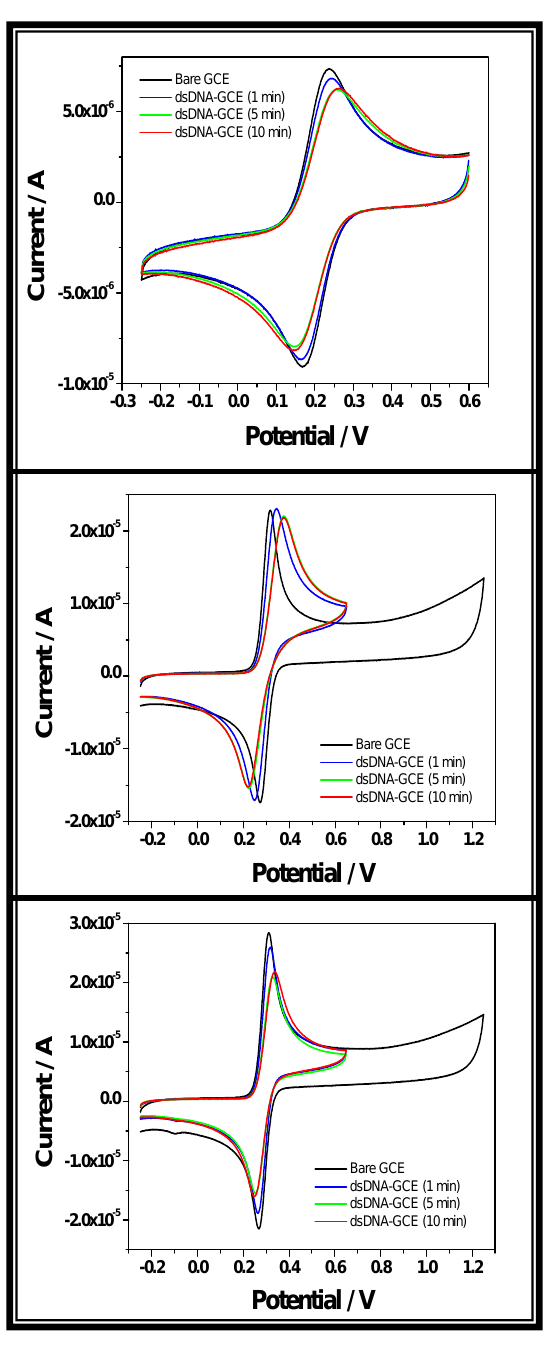
Figure 2. Cyclic voltammograms for 5.0 x 10 -4 M potassium ferricyanide (A), catechol (B) and dopamine (C) at bare GCE (black) and at dsDNA-modified-GCE obtained by adsorption from a 30.0 ppm dsDNA solution for 1.0 min (blue), 5.0 min (green) and 10.0 min (red). Supporting electrolyte: 0.200 M acetate buffer solution pH 5.0. Scan rate: 0.100